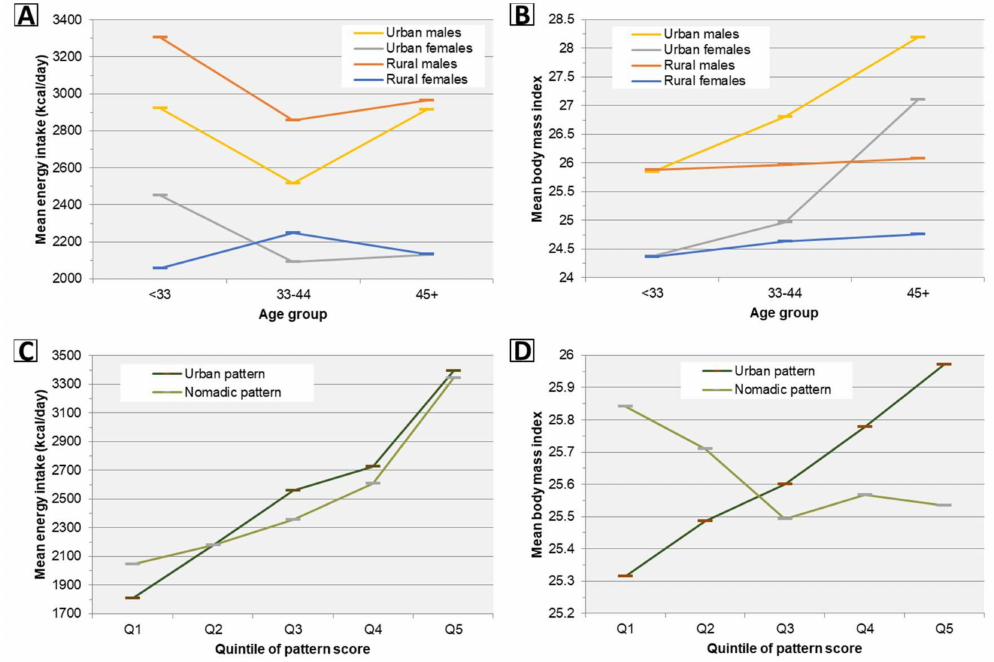
Figure 4. Trends in estimated marginal means of energy intake and body mass index by age and diet pattern scores across subgroups. ( A , B ) Means are estimated using a regression model in which summer or winter mean energy intake ( n = 635) or BMI ( n = 334) are predicted using an age group × urbanicity-sex group interaction term adjusted for province; energy models are additionally adjusted for season and a random intercept per person to account for within-person correlation across seasons. Within both urban males and rural males, adjusted energy intake decreases significantly ( p < 0.05) from < 33 to 33–44 years, and there are no significant di ff erences in linear age trends between any subgroups; see Table 5 for age trends in BMI. ( C , D ) For each diet pattern, means are estimated using a regression model in which summer or winter mean energy intake ( n = 635) or BMI ( n = 334) are adjusted for quintile of pattern score, age in years, sex, urbanicity, and province; energy models are additionally adjusted season and a random intercept per person. See Table 9 for trends in energy intake and BMI across quintiles of pattern